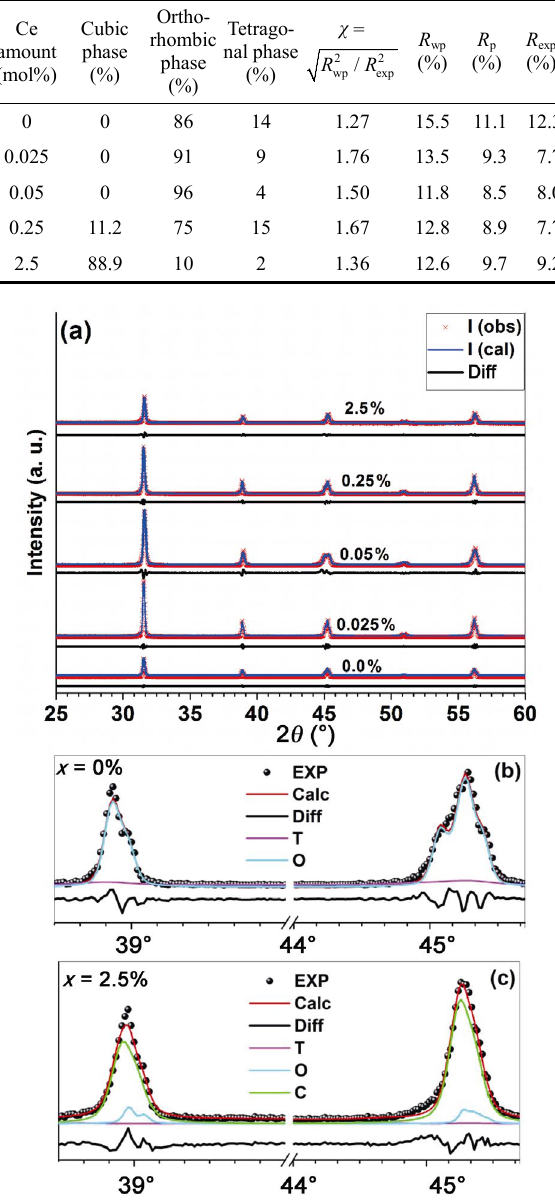
Fig. 2 (a) Rietveld refinement of the XRD patterns of BCCe x ZT ceramics and the magnified peaks at 2 θ = 39° and 45° for (b) x = 0 and (c) x = 2.5.